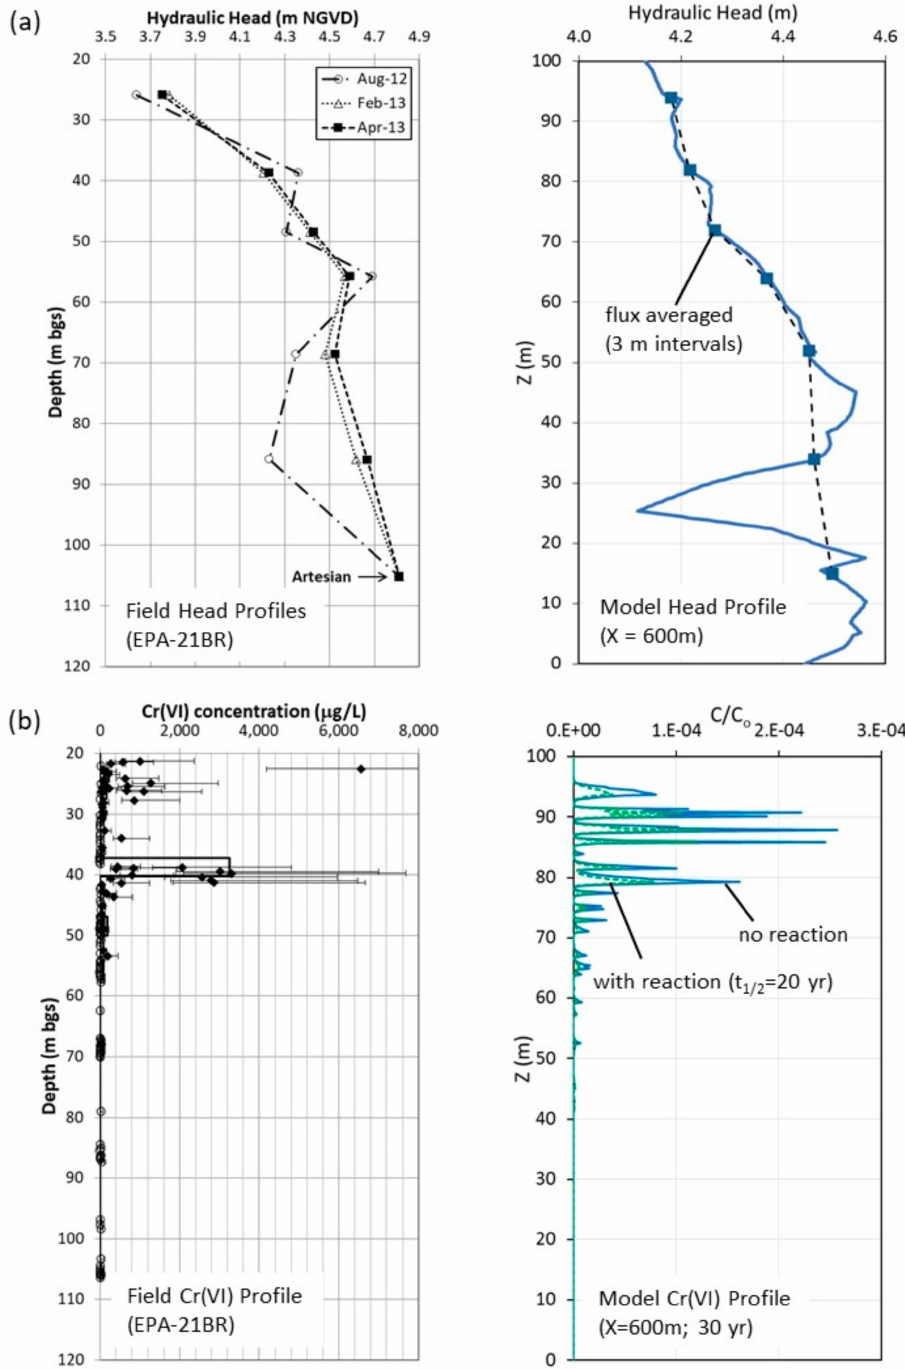
Figure 11. Field versus DFM model comparison of ( a ) hydraulic head profiles and ( b ) Cr ( VI ) profiles. The field head profiles in ( a ) were measured in the EPA-21BR MLS and model profiles extracted from DFM flow simulation at X = 600 m (full head profile and flux-averaged values over 3 m intervals at similar relative depths as the field profiles). The field Cr ( VI ) profile in ( b ) shows matrix porewater concentrations measured on EPA-21BR core samples and model profiles extracted from DFM simulation at X = 600 m at 30 years for scenarios without (solid line) and with (dashed line)